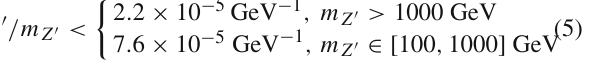
(cid:11) 2 . 2 × 10 − 5 GeV − 1 , m Z (cid:2) > 1000 GeV g (cid:2) / m Z (cid:2) <